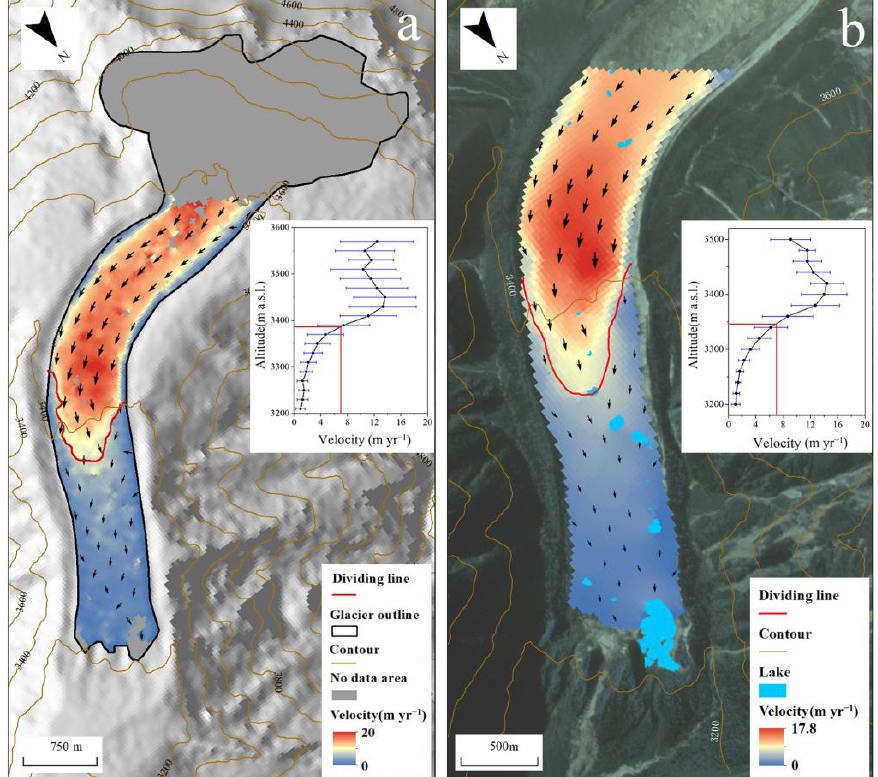
Figure 4. Spatial pattern of surface velocity of Zhuxi Glacier in 2016–2020 ( a ) and in 2020–2021 ( b ), together with their mean surface velocity changes within 20-m elevation bands (black dots) with standard deviation (blue horizontal bars) in each inset panel. The red beelines indicate the position of an average surface velocity of 7 m yr − 1 and the corresponding altitude. The dividing line showed in red is the isopleth with a surface velocity of 7 m yr − 1 .